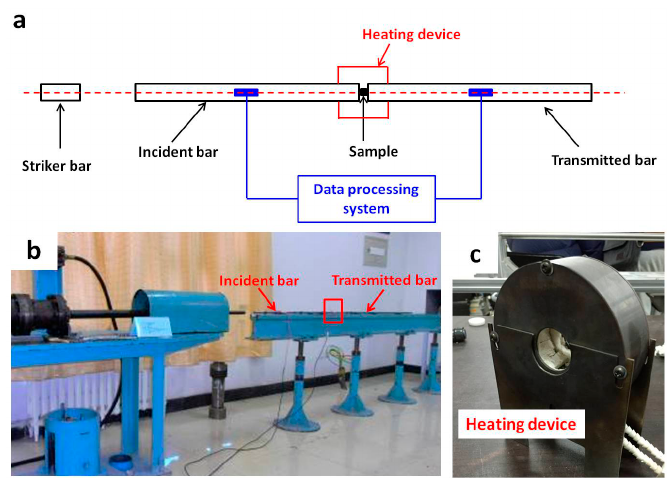
Figure 1. ( a ) Schematic diagram of the split Hopkinson pressure bar (SHPB) system; ( b ) picture of the SHPB system; ( c ) picture of the heating device.